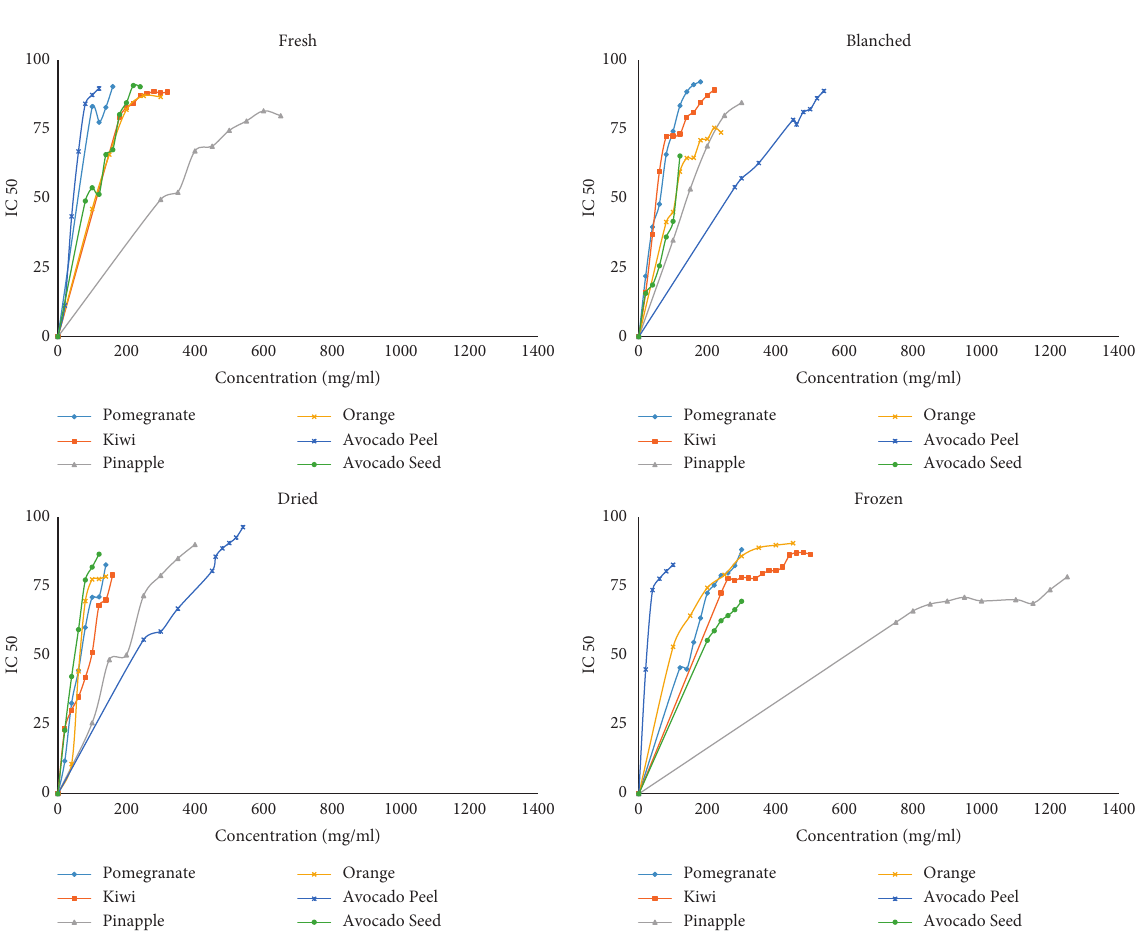
Figure 2: Diphenyl-1-picrylhydrazyl (DPPH) free radical scavenging activity of dried, blanched, freezed, and fresh fruit by-products. Table 1: Means of total flavonoid content (TFC, mg/100g), total phenolic content (TPC, mg/100g), reducing power (FRAP < 0.1 g/100ml), and DPPH inhibition (IC50, %) of avocado peel, avocado seeds, kiwi fruit, orange peel, pineapple peel, and pomegranate skin during